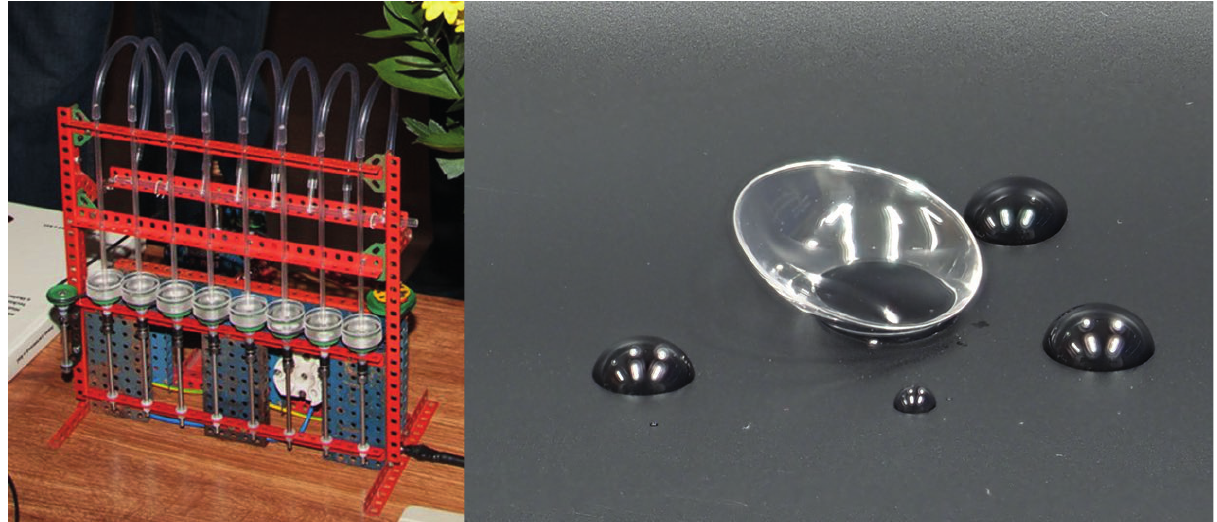
Figure 1. Replica of the building set Merkur (improvised lens-machine) for spin-casting (left ), an example of a soft hydrophilic PHEMA- based contact lens